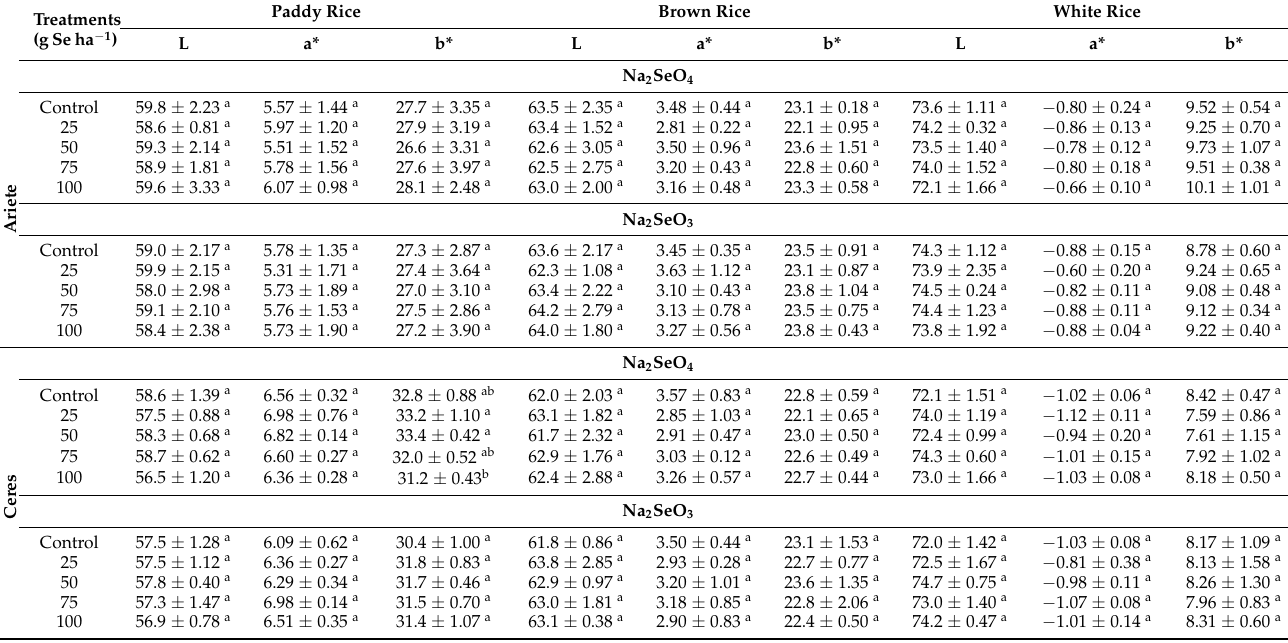
Table 4. Color parameters of the paddy, brown and white rice grains of O. sativa , cultivars. Treatments (gSeha − 1